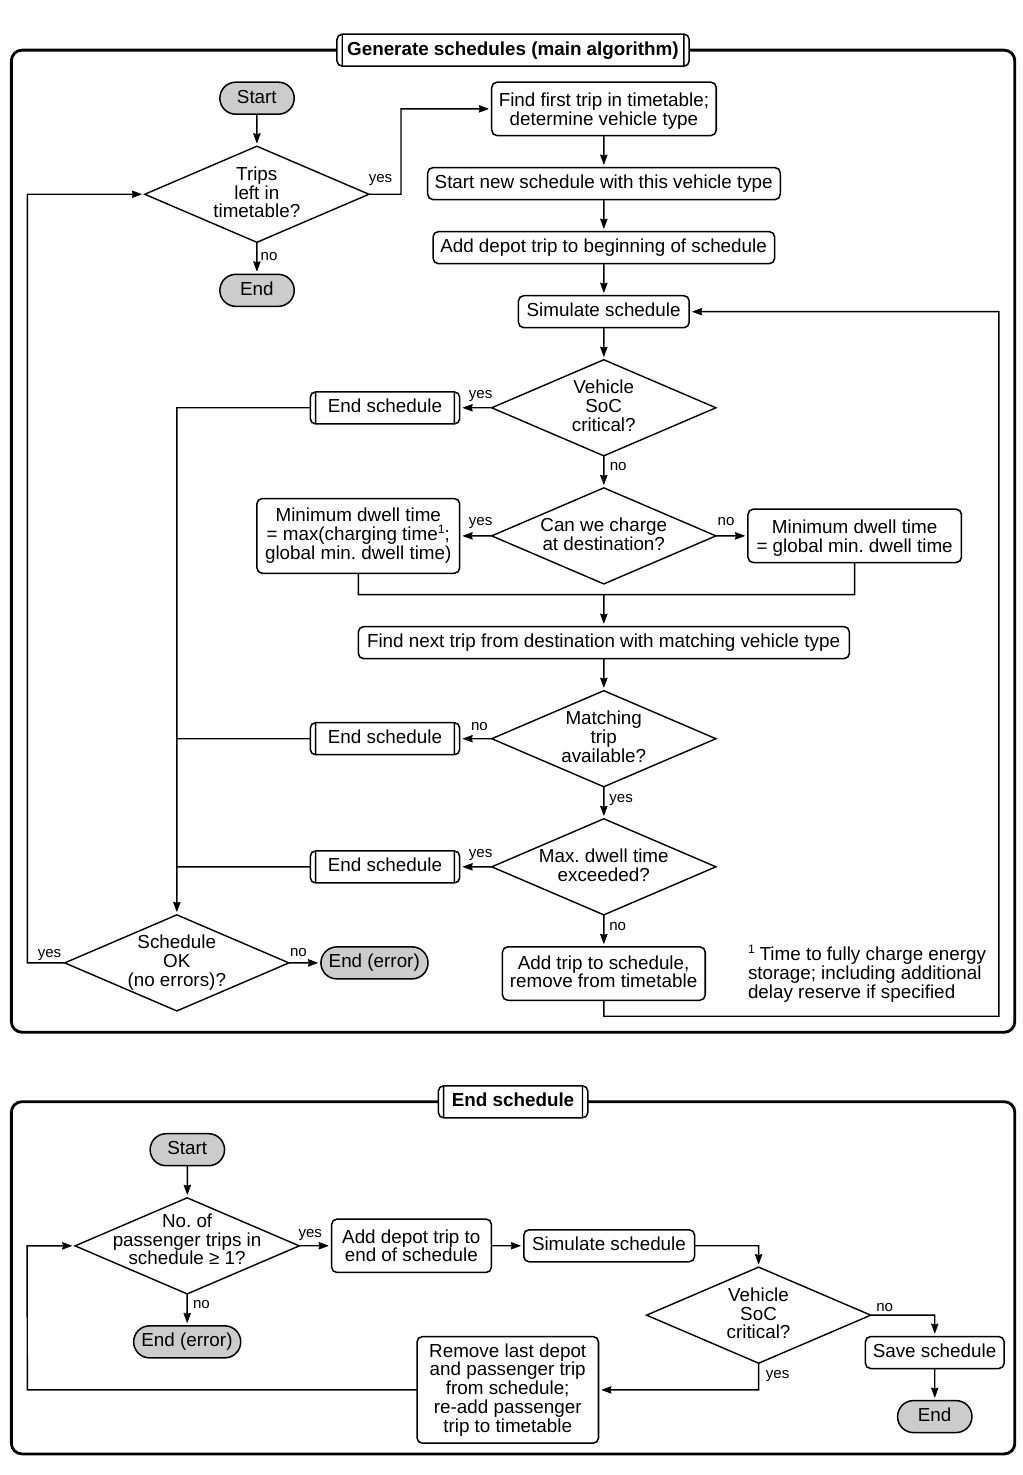
Figure A1. Scheduling algorithm, stage